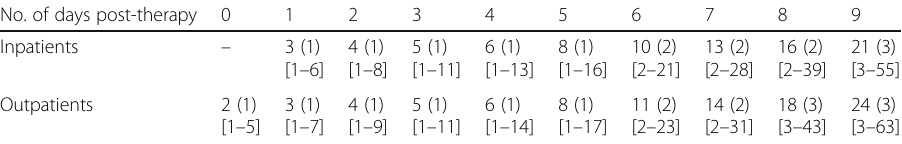
allowed on public transport at 0 – 9 days post-therapy to limit dose for members of the public to 0.3 mSv per